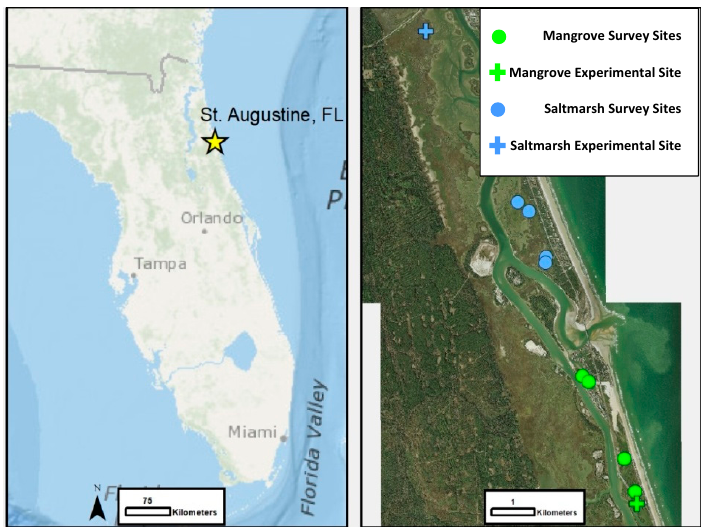
Figure 1. Map of Florida (left) and the St. Augustine, FL study region (right) with experimental and survey sites. The yellow star marks mangrove-saltmarsh ecotone in St. Augustine, FL. A green cross denotes the mangrove experimental site; green circles denote the mangrove survey sites; a blue cross identifies the saltmarsh experimental site; and blue circles identify the saltmarsh survey sites. Both basemaps provided by State of Florida.